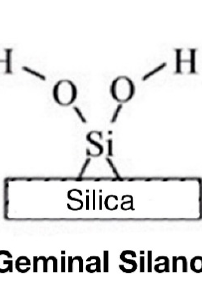
Figure 1. Types of silanol groups on the surface of porous silica [14].